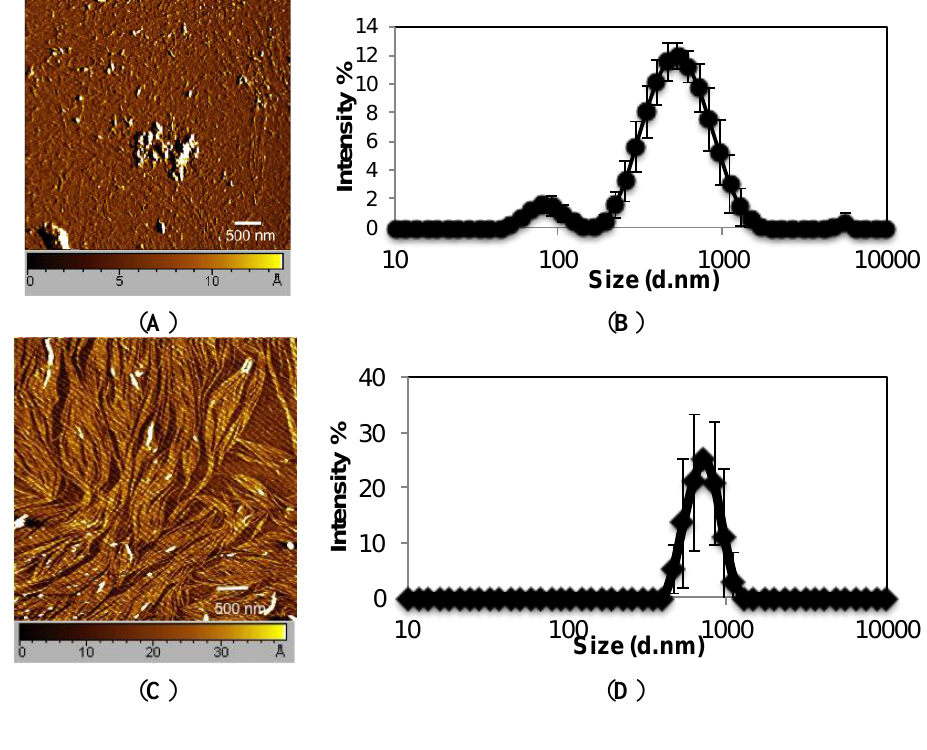
Figure 2. Nanostructure of ( A ) EAR8-II and ( C ) EAR8-II-THP complex by tapping mode atomic force microscopy; Intensity-based particle size distribution of ( B ) EAR8-II and ( D ) EAR8-II-THP complex in aqueous solution by dynamic light scattering. EAR8-II concentration is 0.5 mg/mL, and THP concentration is 0.1